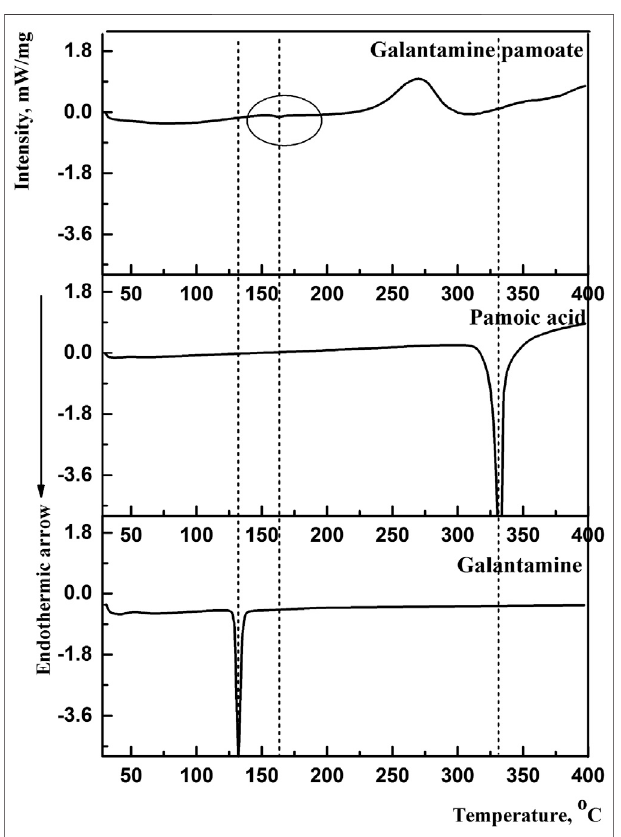
FIGURE 2 | DSC curves of galantamine, pamoic acid and